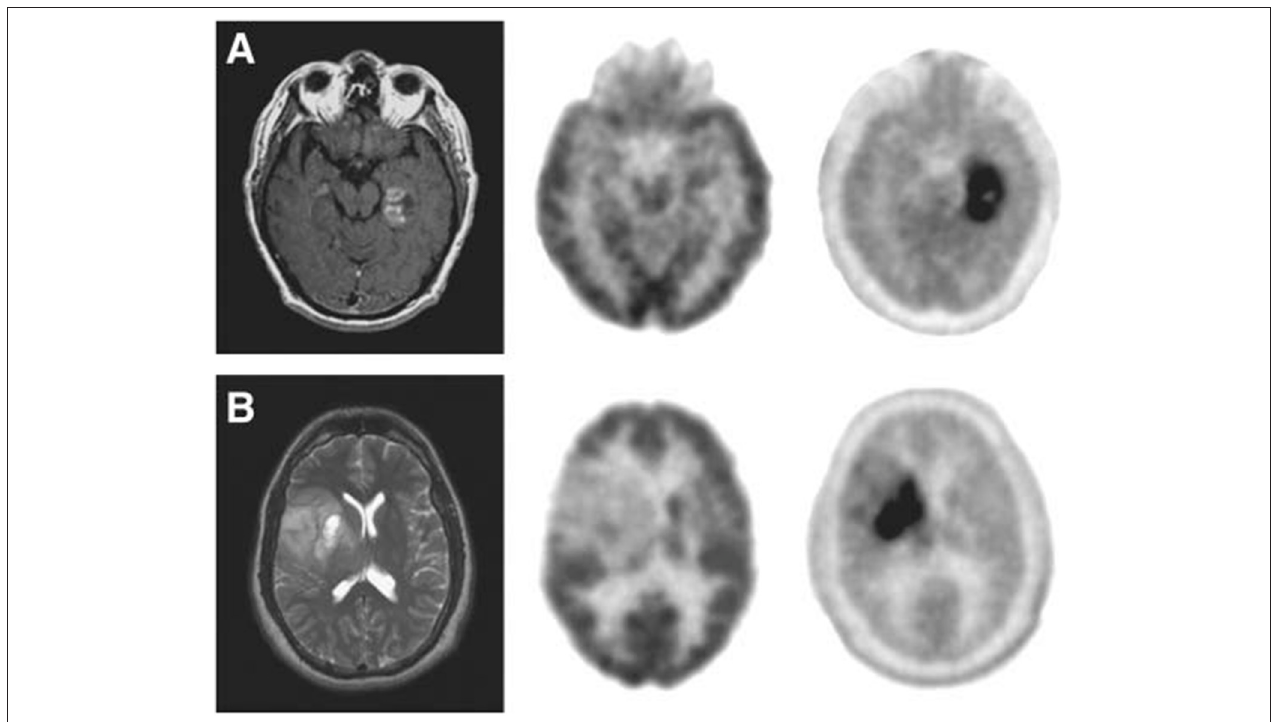
FIGURE 5 | (A) Images of a newly diagnosed glioblastoma. (B) Images of a newly diagnosed World Health Organization grade II oligodendroglioma. Magnetic resonance (left), 18 F-FDG PET (middle), and 18 F-FDOPA PET (right). 18 F-FDOPA PET imaging illustrated significantly better visualized and defined tumor with adequate contrast. This figure is reproduced with permission from Chen et al. (2006), Figure 2 © by the Society of Journal of Nuclear Medicine Imaging, Inc.